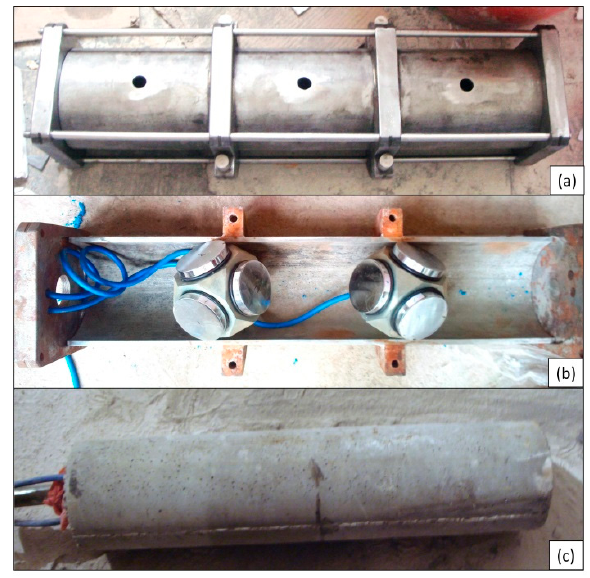
Figure 9. Production process for the column transducers: ( a ) Steel mold; ( b ) placing the 3D comprehensive pressure transducers; ( c ) column transducer. Table 2. Average value of cement mortar obtained from uniaxial compression